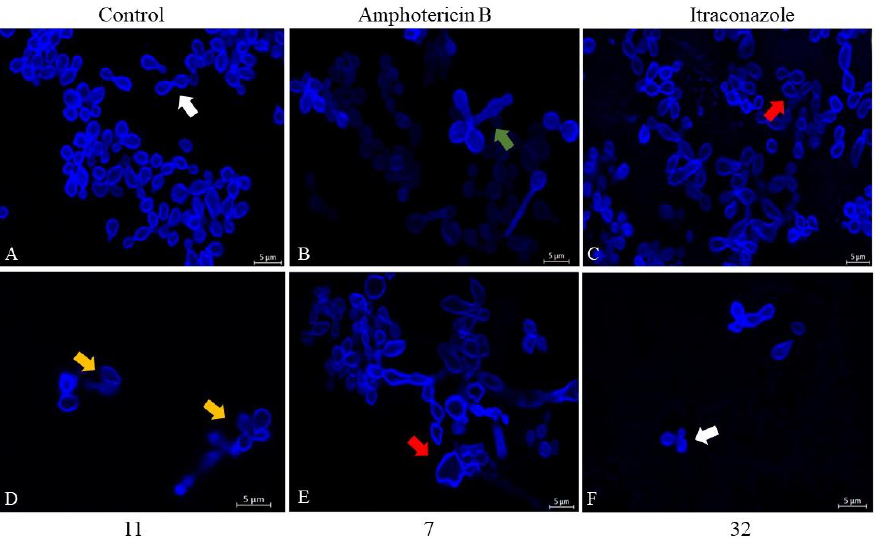
Figure 10. Confocal laser scanning microscopy images (CLSM) of fungal H. capsulatum EH-315 treated with 11 , 7 , 32 , ITZ, and AmB. In CLSM images, the cell wall was stained with calcofluor white. Cells treated with compound 11 ( D ) showed small cell wall faults (orange arrow). However, cells treated with AmB ( B ) showed prolongations (green arrow). ITZ ( C ) and 7 ( E ) caused irregularities in cell shape (red arrows). Both the cells without treatment ( A ) and those treated with the compound 32 ( F ) had a continuous and regular wall (white